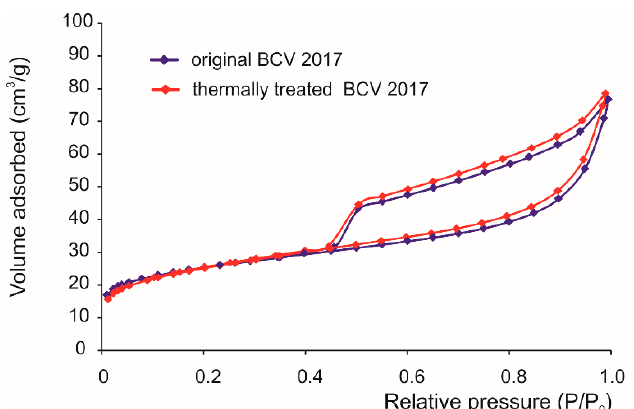
Figure 8. Absorption and desorption isotherms for original and thermally treated bentonite BCV 2017.